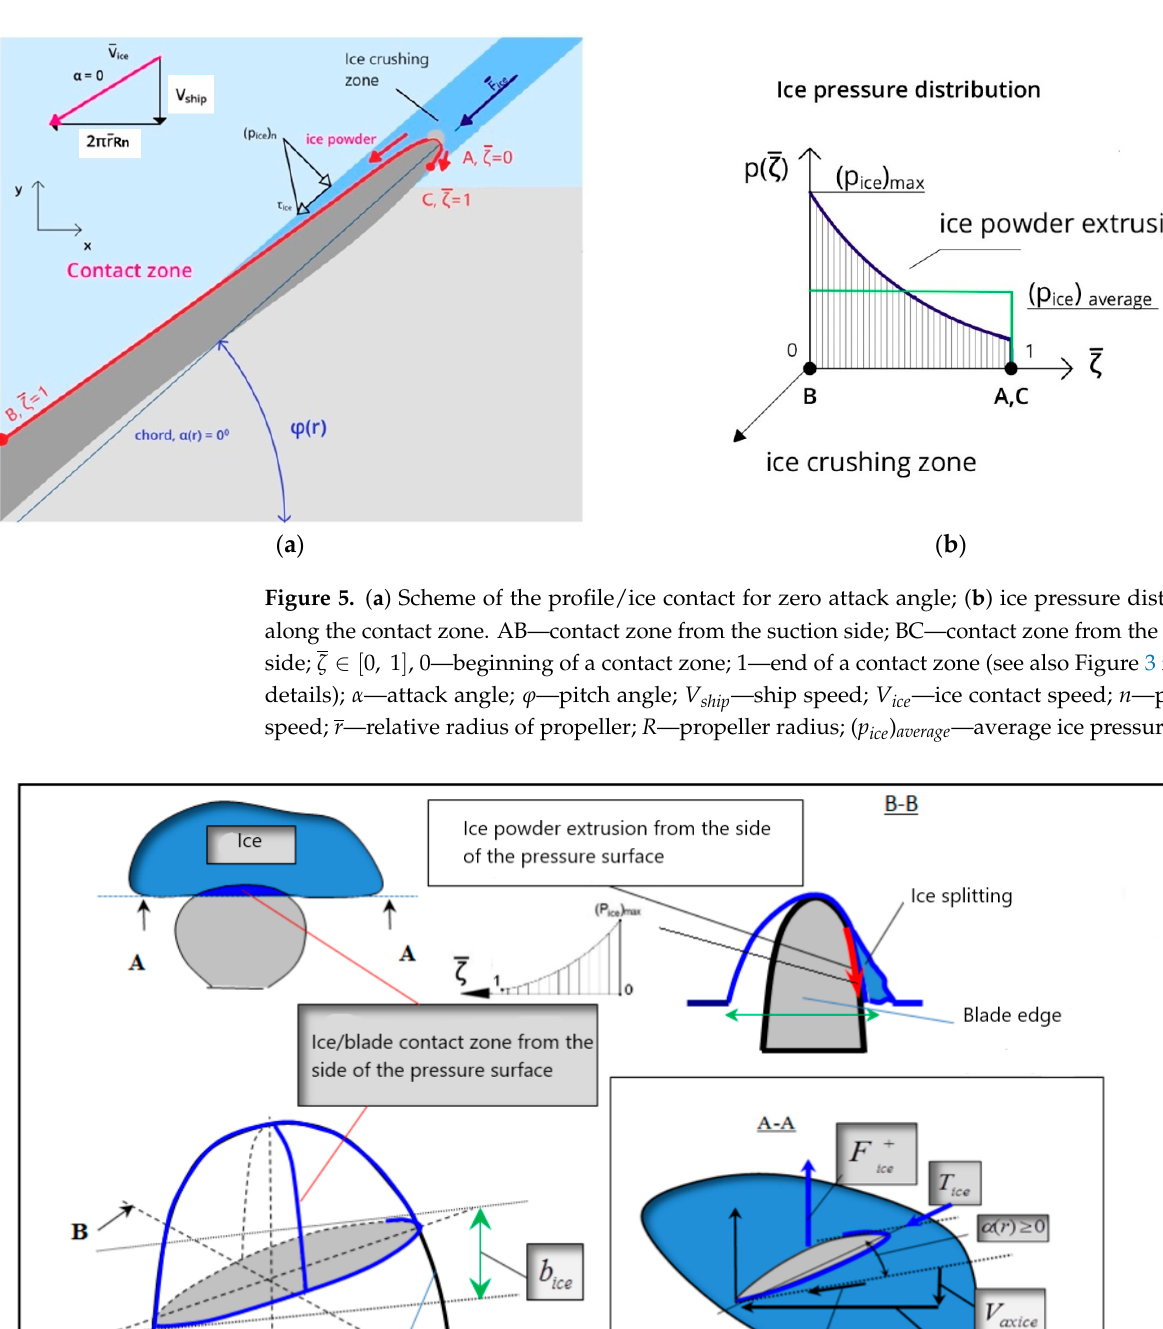
Figure 6. Scheme of interaction of the peripheral sections of the blade with an ice block, the second type of ice milling [5,8]. F + —forward axial ice force, ζ ∈ [ 0, 1 ] , 0—beginning of a contact zone; 1—end of a contact zone; b ice —width of a cut by peripheral cross-sections. For more information, refer to [7,8].